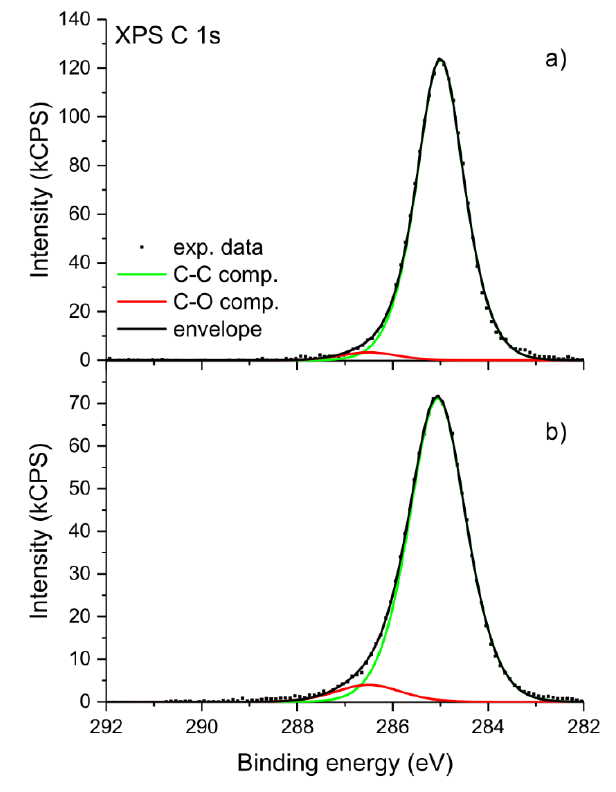
Figure 3. High-resolution X-ray photoelectron spectra of the unoriented i -PP + 5% of Sillikolloid before ( a ) and after ( b ) one-month UV irradiation.